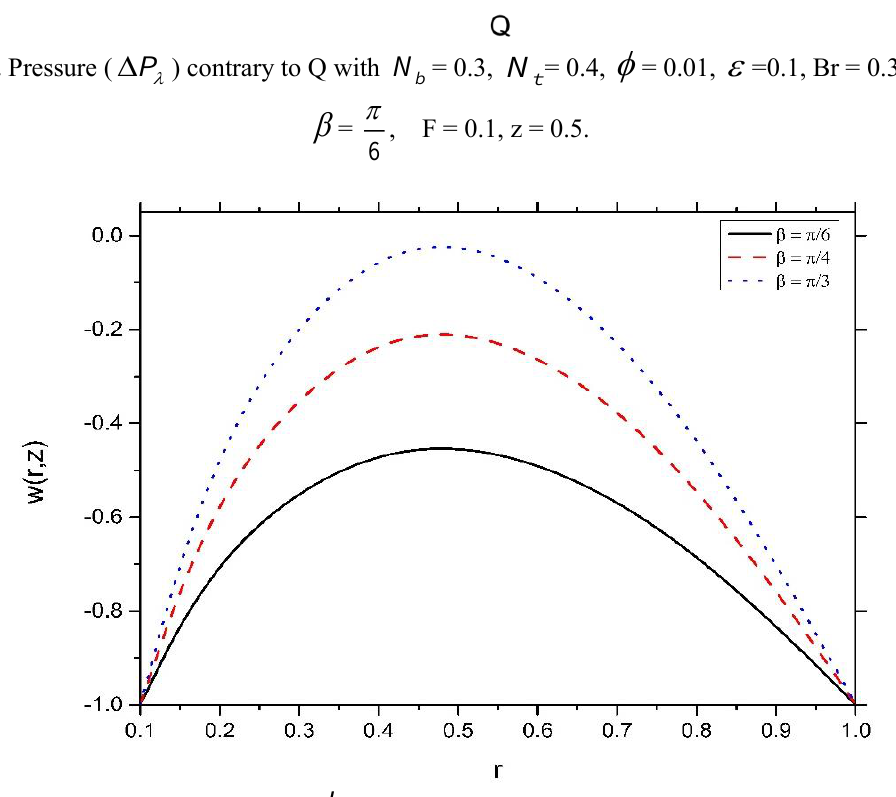
N = 0.3,  = 0.01,  =0.1, Gr = 0.5, t